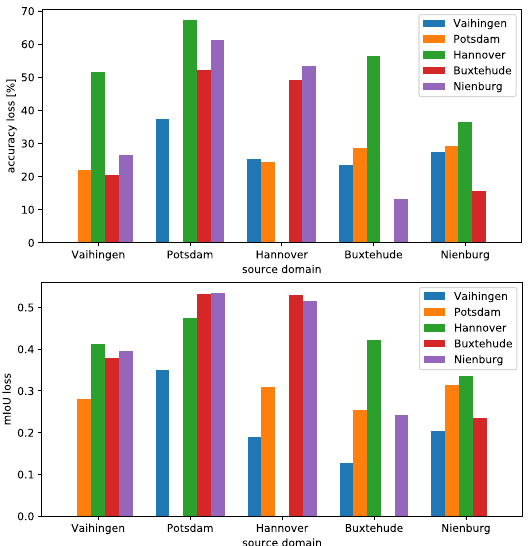
Figure 8. Accuracy and mIoU loss when using a model trained on one domain on another domain